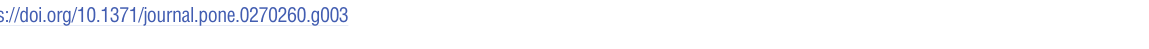
PLOS ONE | https://doi.org/10.1371/journal.pone.0270260 July 6,